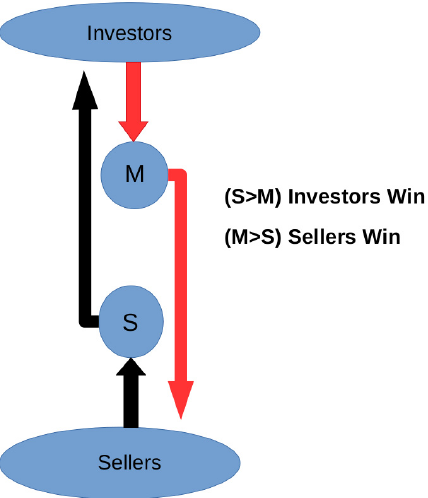
Fig. 1. Schematic diagram for the model. The group with smaller investment gets more return and hence the winner. Therefore, the group with smaller investment can be though of as the